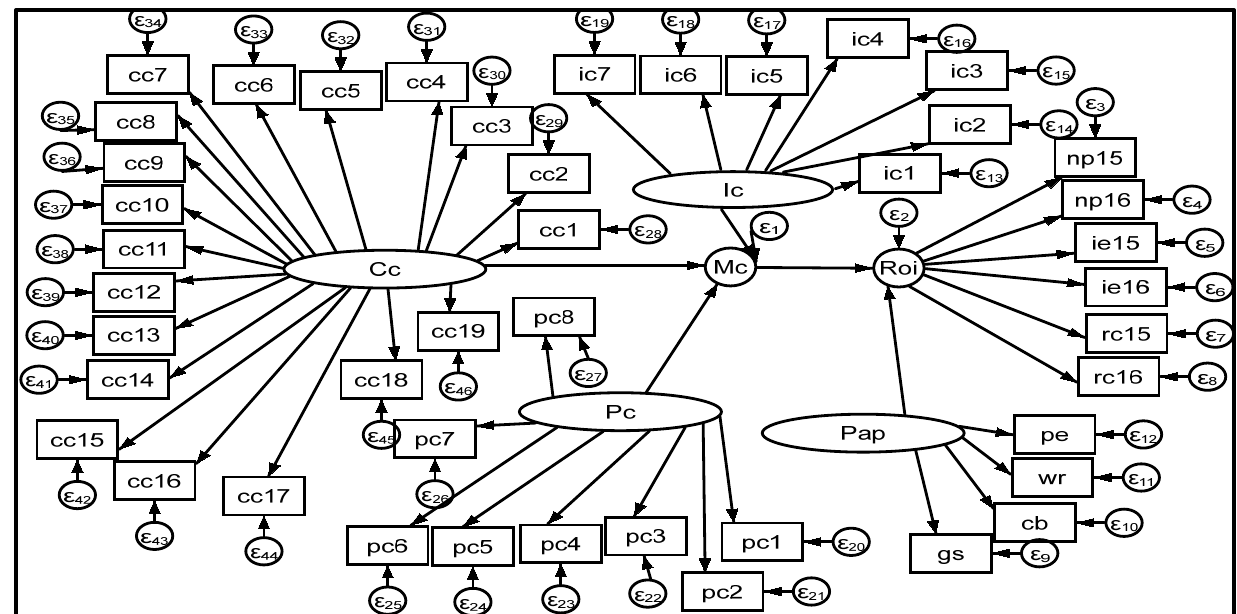
Figure A2. Structural Equation Model (SEM) conceptual framework for return on investment as a measure of performance. Note: Definitions of the variable acronyms are provided in Table 4 in the text.